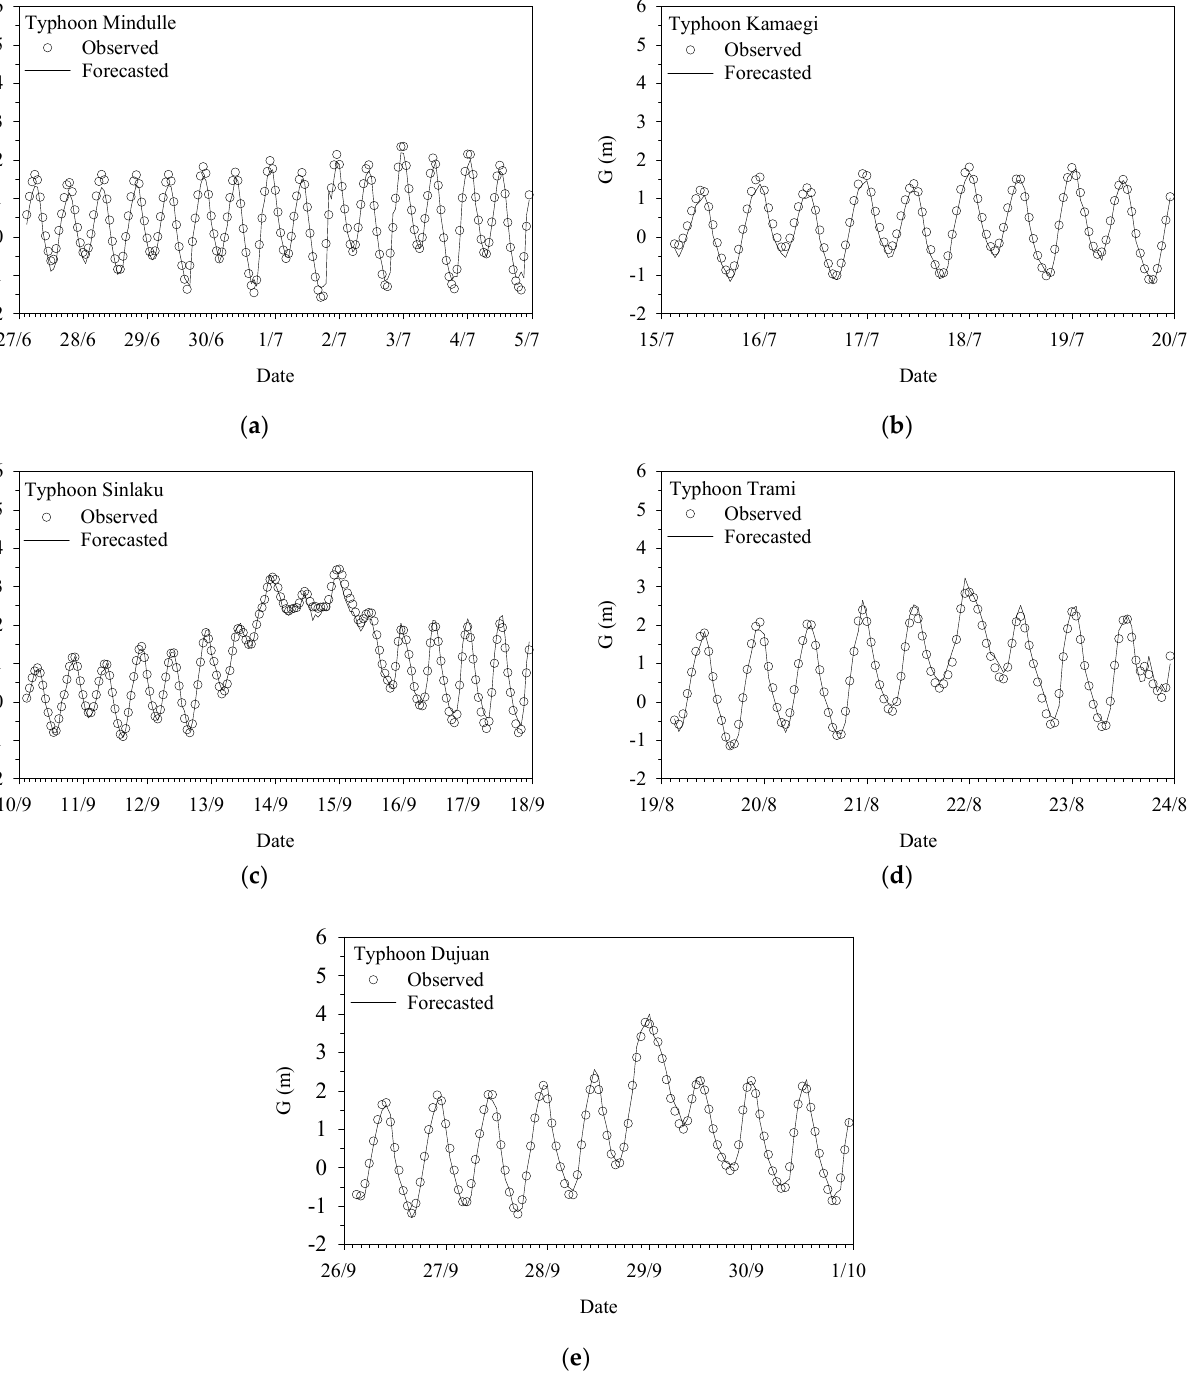
Figure 10. Accuracy of 1 h ahead water−stage forecasting during typhoons at verification phase: ( a ) Typhoon Mindulle l; ( b ) Typhoon Kamaegi; ( c ) Typhoon Sinlaku; ( d ) Typhoon Trami; ( e ) Typhoon Dujuan.